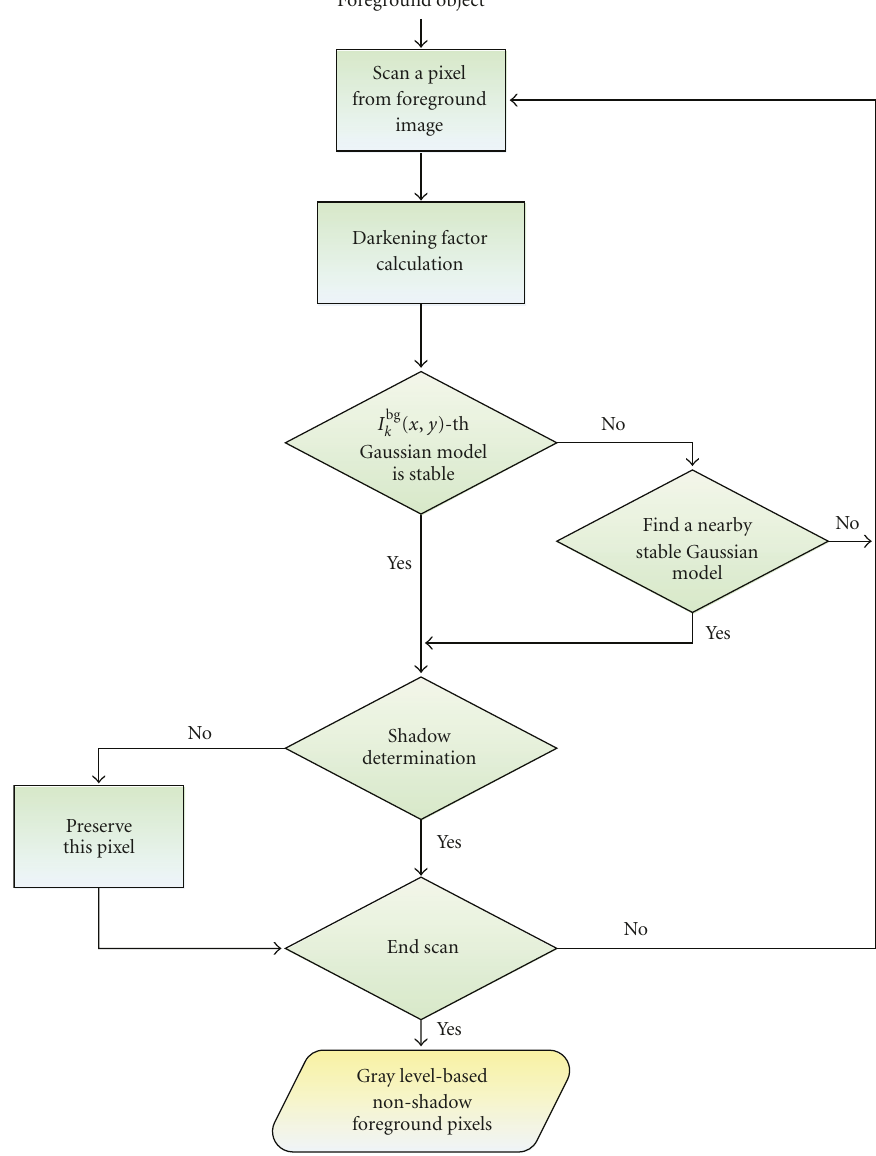
Figure 19: Flowchart of the nonshadowed pixel determination.